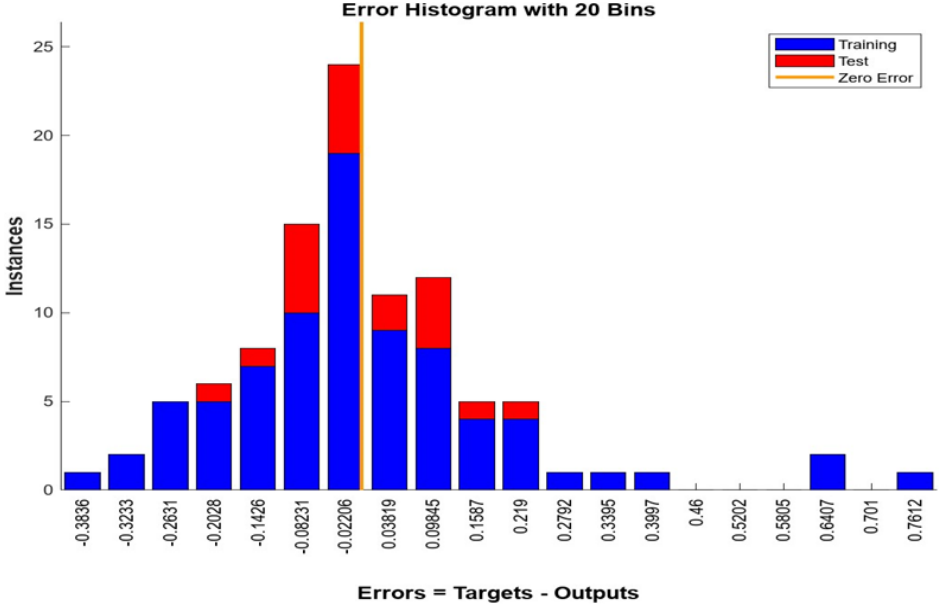
Figure 12. Proposed model prediction error histogram, the blue bars correspond to training, while the red bars refer to the test error.